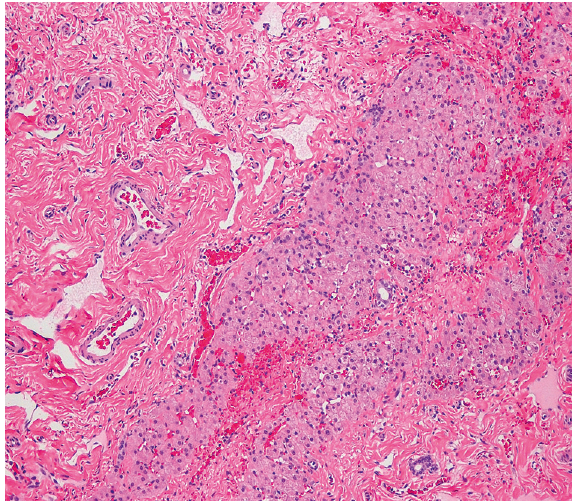
Figure 3: Puzzle-shaped pieces of hepatic parenchyma embedded in hyalinized matrix (hematoxylin and eosin stain with 200x